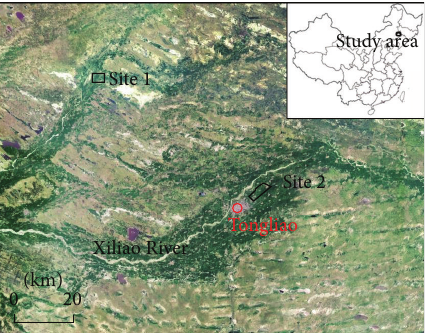
Figure 1: Location of the study site. Site 1 shows the maize growth area that was used to study the temporal changes of the heavy metal concentrations in soils and maize organs. Site 2 is the control area of wastewater and/or groundwater irrigation and was used to study the impacts of wastewater irrigation on the